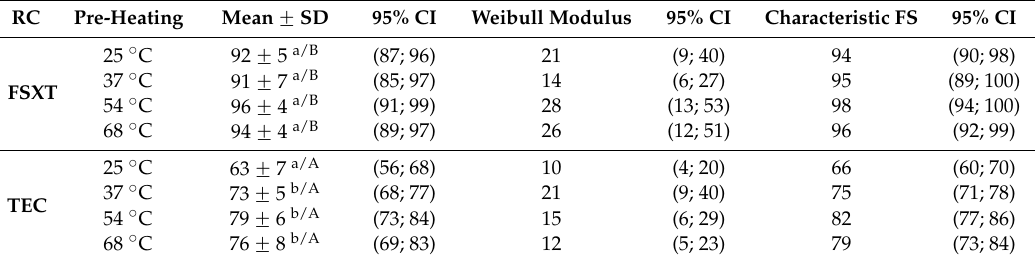
Mean with standard deviation for flexural strength (FS) (MPa) appendant Weibull modulus and characteristic FS as well as 95% confidence interval (CI) for each tested RC by each pre-heating